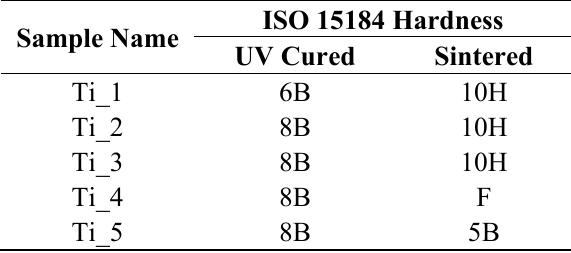
Table 1. Hardness data for 3-layered samples.